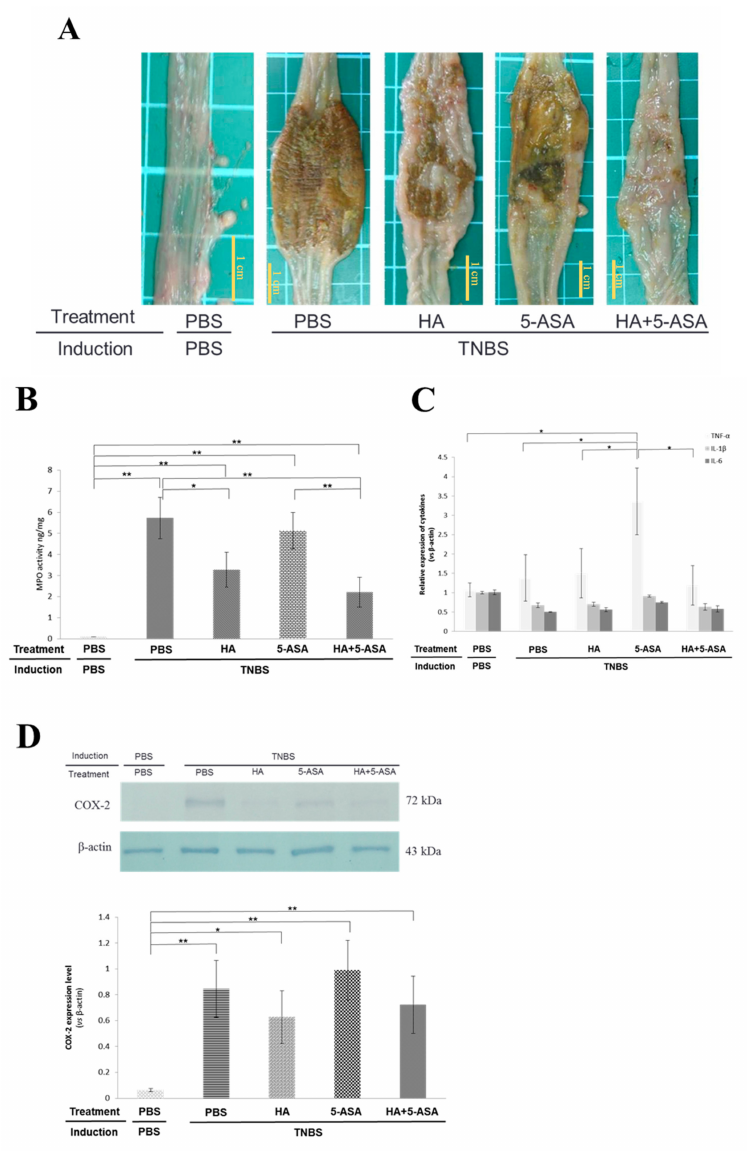
Figure 3. The macroscopic inner appearance, MPO activity, and proinflammatory cytokine and COX-2 expressions in the colon tissues of rats following induction (PBS or TNBS) and treatment (PBS, HA, 5-ASA, and HA + 5-ASA, respectively). According to the macroscopic inner appearance of the colon, combined treatment with HA and 5-ASA exerts a synergistic protective effect on TNBS-induced colitis compared with other treatments following TNBS induction ( A ). Combined treatment with HA and 5-ASA exerts the synergistic effects of suppression of MPO activity on TNBS-induced colitis compared with other treatments following TNBS induction ( B ) Related expression of mRNA of TNF- α , IL-1 β and IL-6 genes represent the mean ± SE. Unlike IL-1 β and IL-6, TNF- α gene expression more significantly decreased after combined treatment with HA and 5-ASA than after 5-ASA treatment alone in TNBS-induced colitis ( C ); Data represent the mean ± SE. COX-2 expression significantly decreased after HA treatment alone and combined treatment with HA and 5-ASA compared with either treatment alone (PBS or 5-ASA) in TNBS-induced colitis ( D ); Each bar represented the mean ± SE. The bars with different star were significant different ( p < 0.05 (*), p < 0.01 (**)) from each